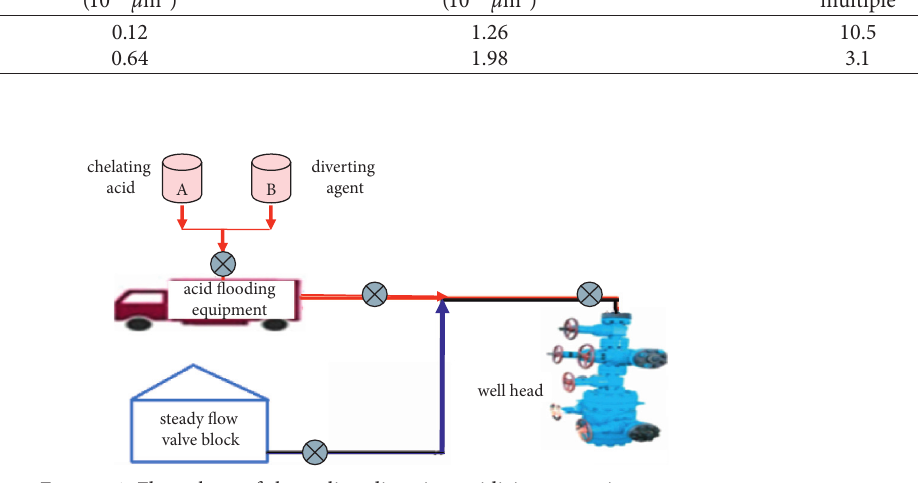
Figure 4: Flow chart of the online diversion acidizing operation